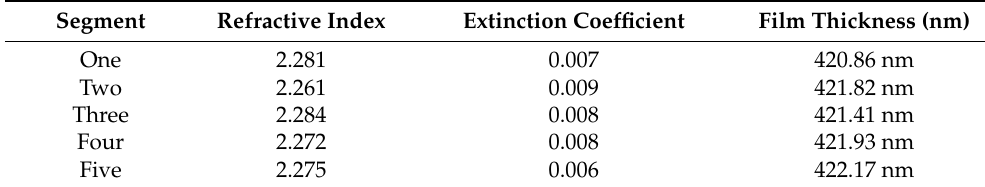
Table 3. Optical constants of Nb 2 O 5 thin film with different